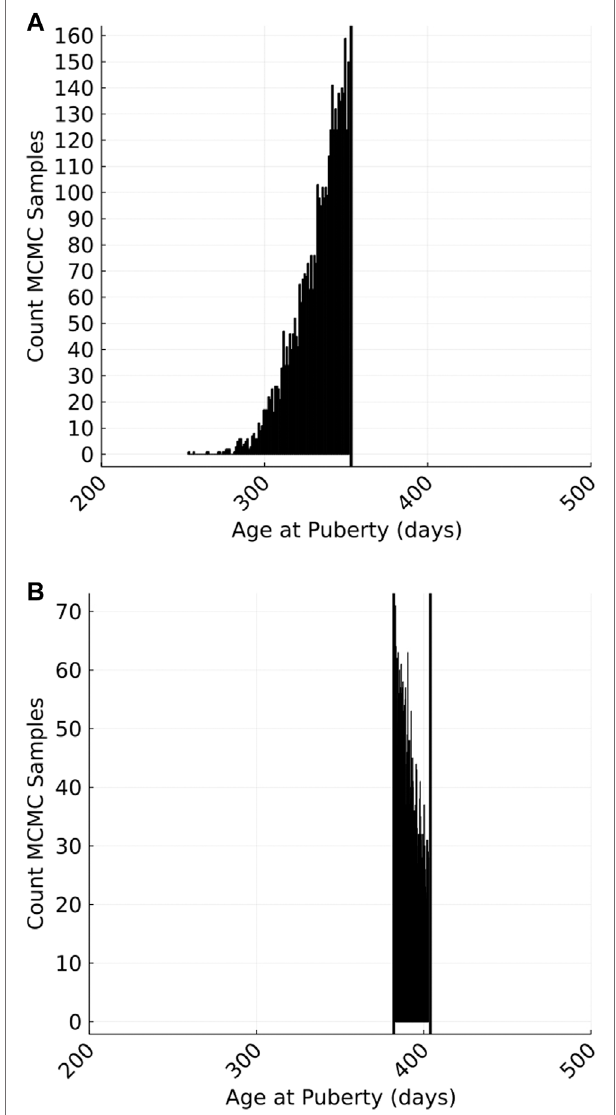
FIGURE 2 | An example of the Markov-chain Monte Carlo (MCMC) sampled phenotypes for a single animal with a left- (A) or interval- (B) censored phenotype. Left censoring occurs where an animal has attained puberty on or before the fi rst herd visit (i.e., sampled phenotypes are truncated by the age of the animal on the fi rst visit). Interval censoring occurs whenananimalreachespubertybetweentwovisits(i.e.,sampledphenotypes are truncated by the age of the animal on the fl anking